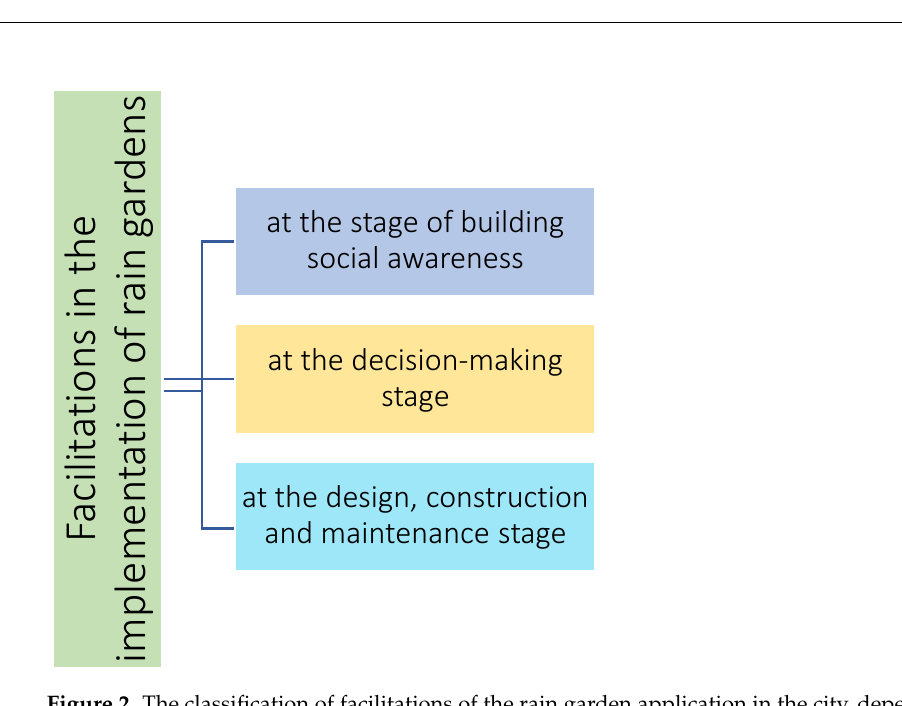
Figure 2. The classification of facilitations of the rain garden application in the city, depending on the implementation stage of the